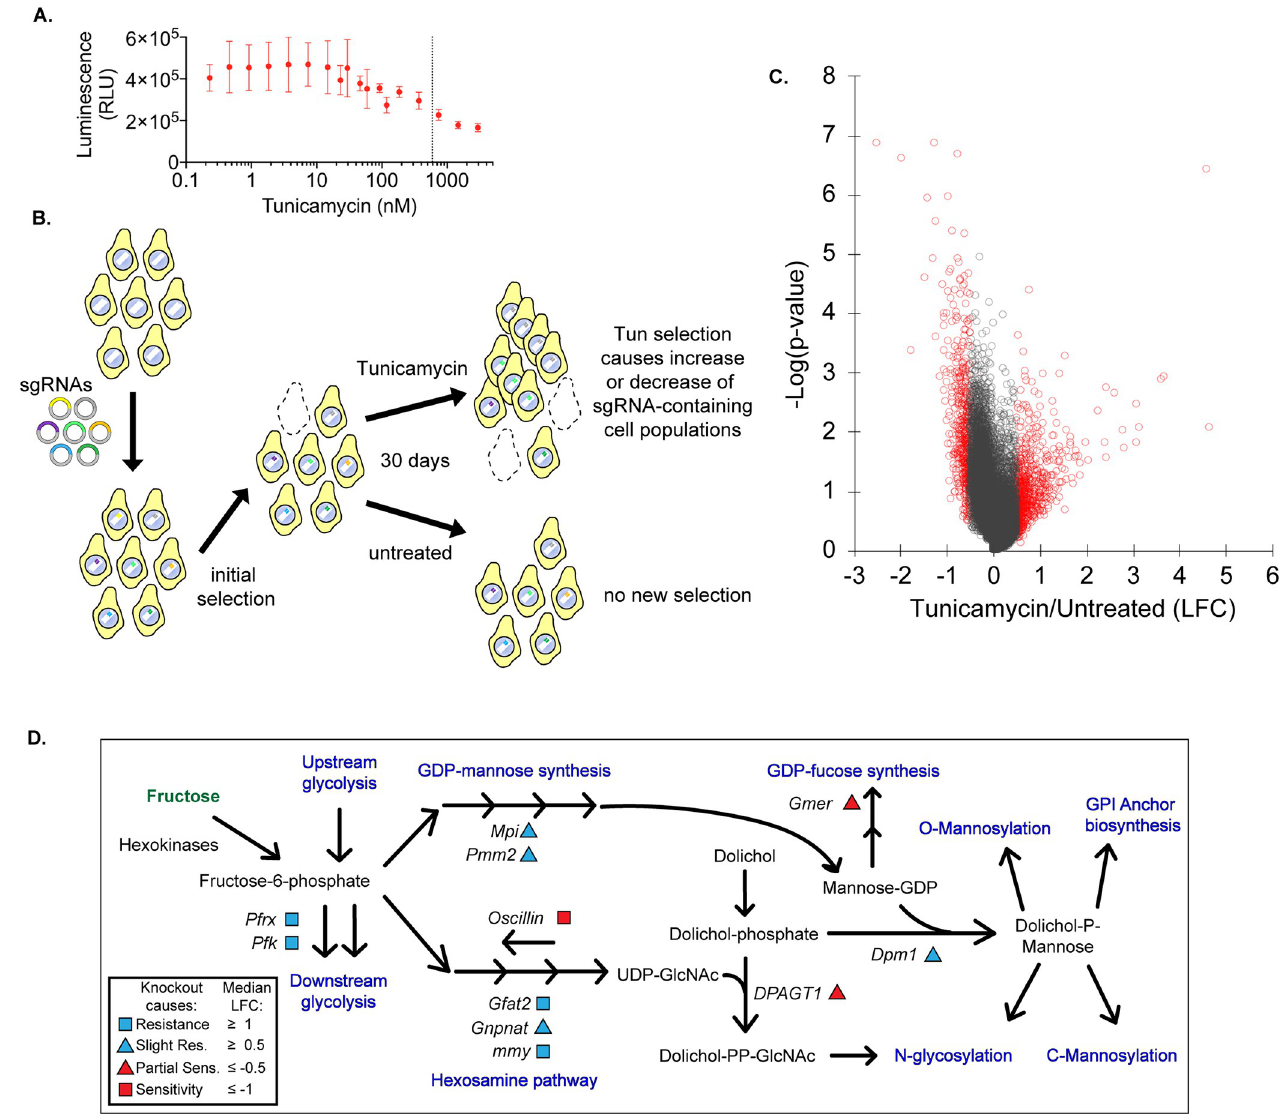
Fig 1. A survival screen reveals hexosamine, glycolysis, and GDP-mannose synthesis in resistance to DPAGT1 loss. (A) We used a cell titer assay to determine the concentration of Tun capable of reducing cell growth rate by ~50% for use in both follow-up screens. (B) We introduced a whole genome guide RNA library into Drosophila cells stably expressing constitutive Cas9. Pooled cell populations were grown for 30 days either untreated or with Tun. Final cell populations were sequenced for sgRNA abundance to determine candidate genes implicated in Tun resistance or sensitivity. (C) Volcano plot of survival screen. Red dots indicate genes with an absolute lfc value of � 0.5 or � -0.5. (D) A simplified model of one set of highly enriched pathways for gene knockouts causing resistance or sensitivity. Note that only genes whose knockout provided resistance or sensitivity are labeled.